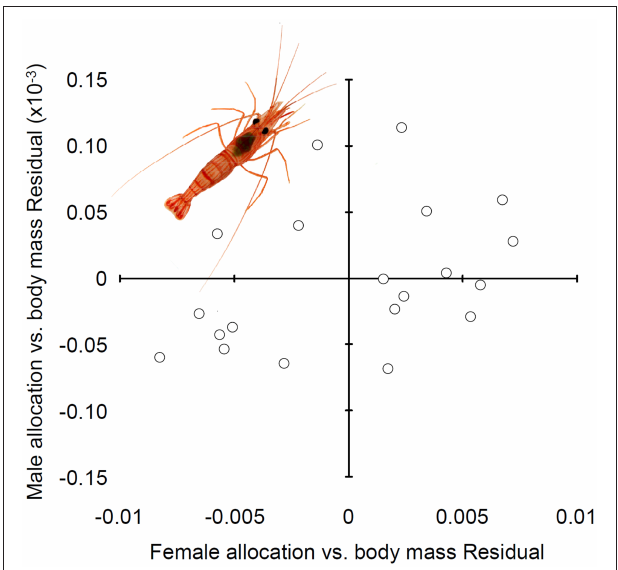
FIGURE 4 | Relationship between male and female allocation in hermaphrodites of Lysmata wurdemanni . All measurements are in grams (g) of dry